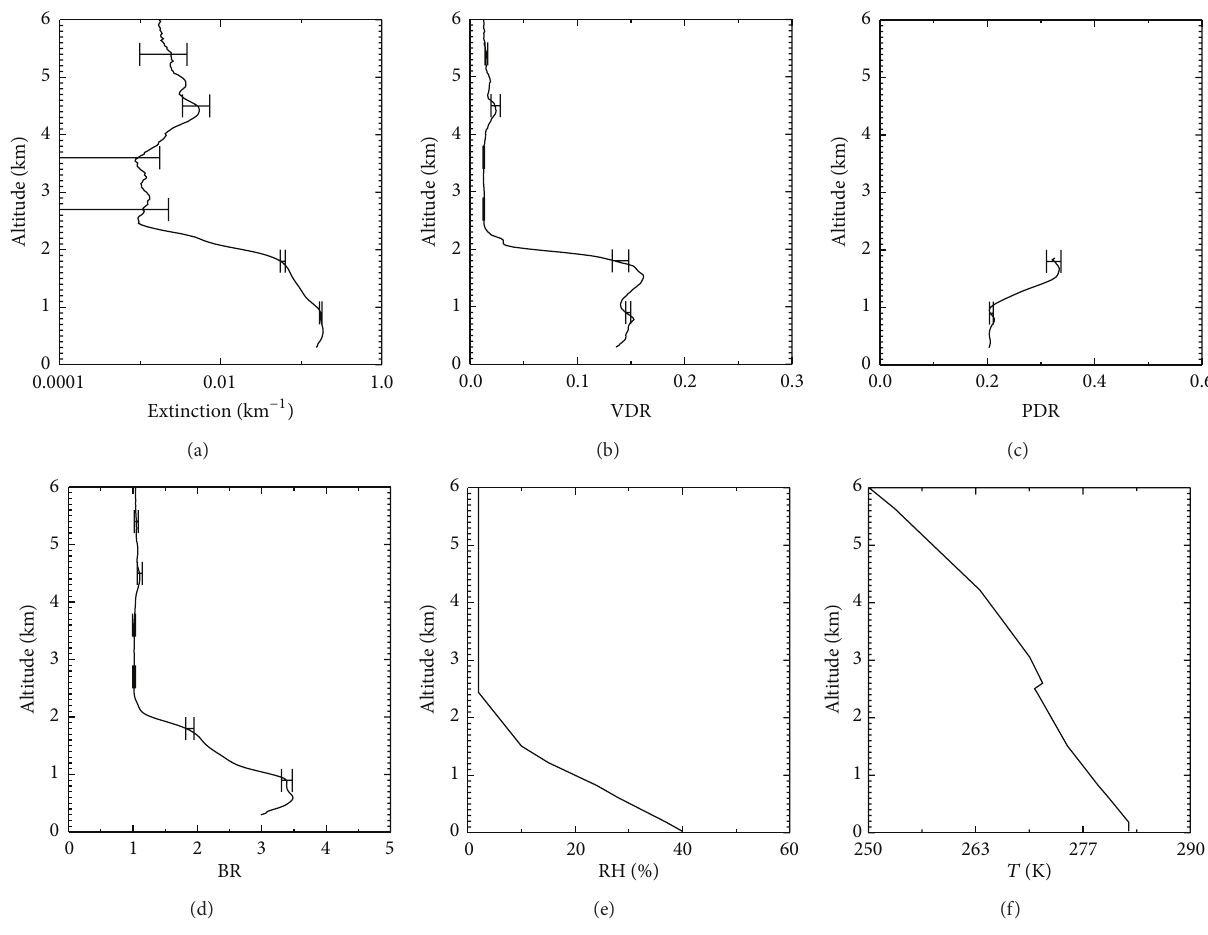
Figure 8: Same as Figure 4, except for the dates, 7 December